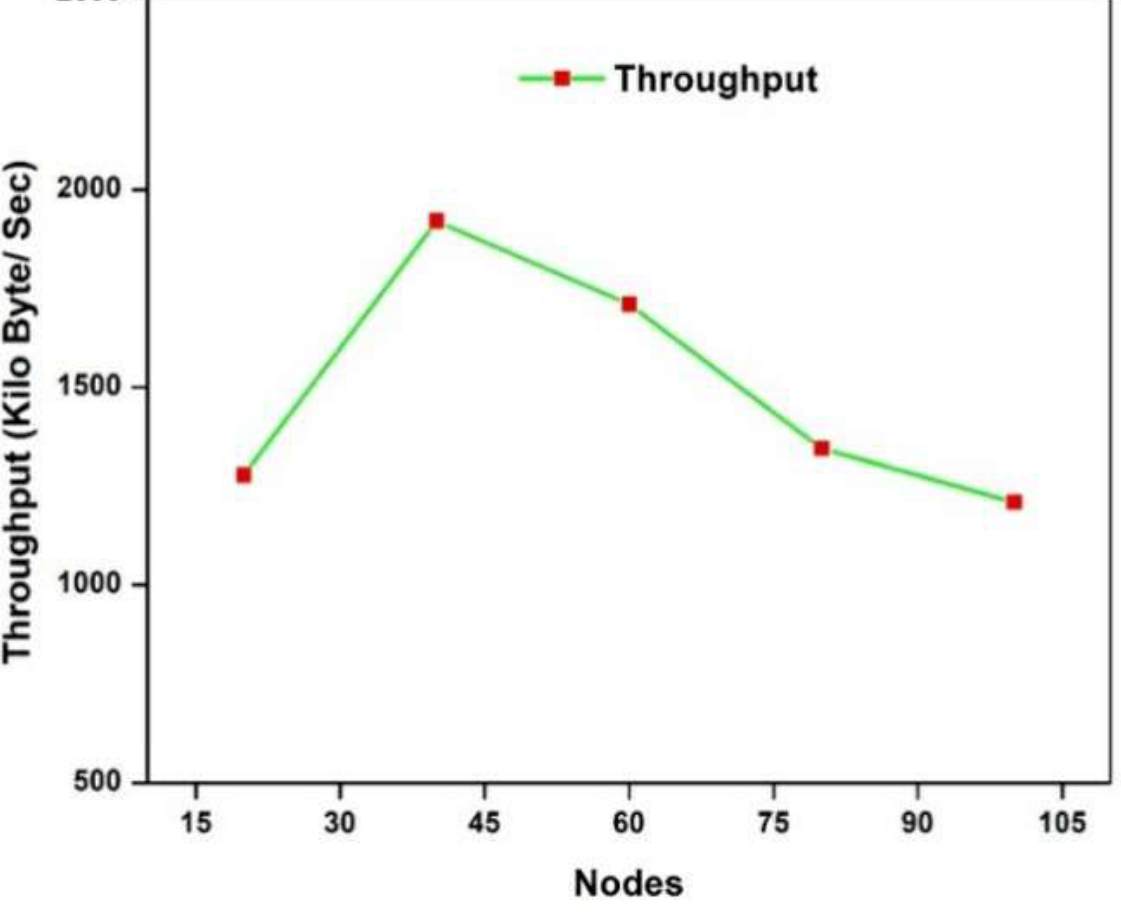
Figure 12. Throughput of the proposed method.